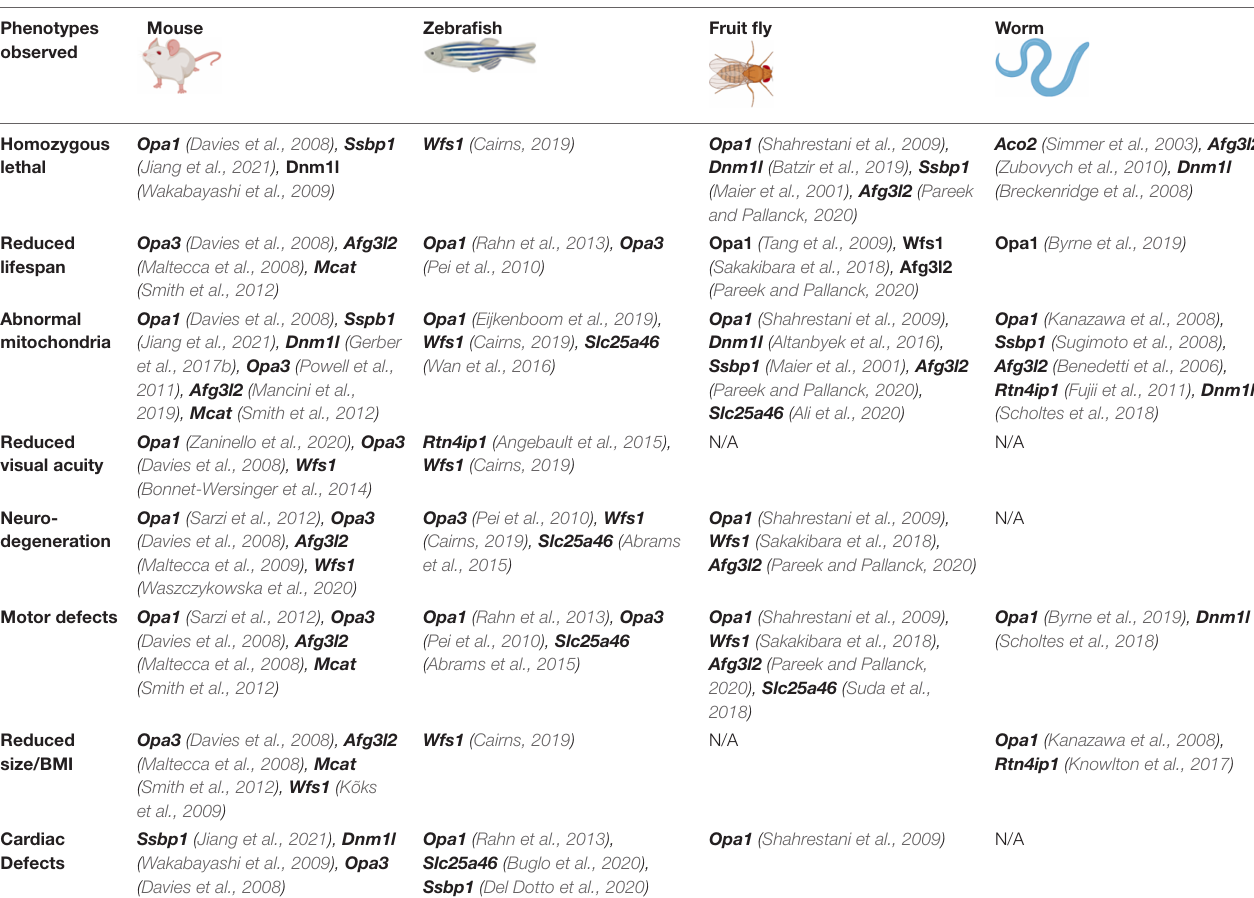
TABLE 2 | Summary of phenotypes observed in in vivo models of autosomal